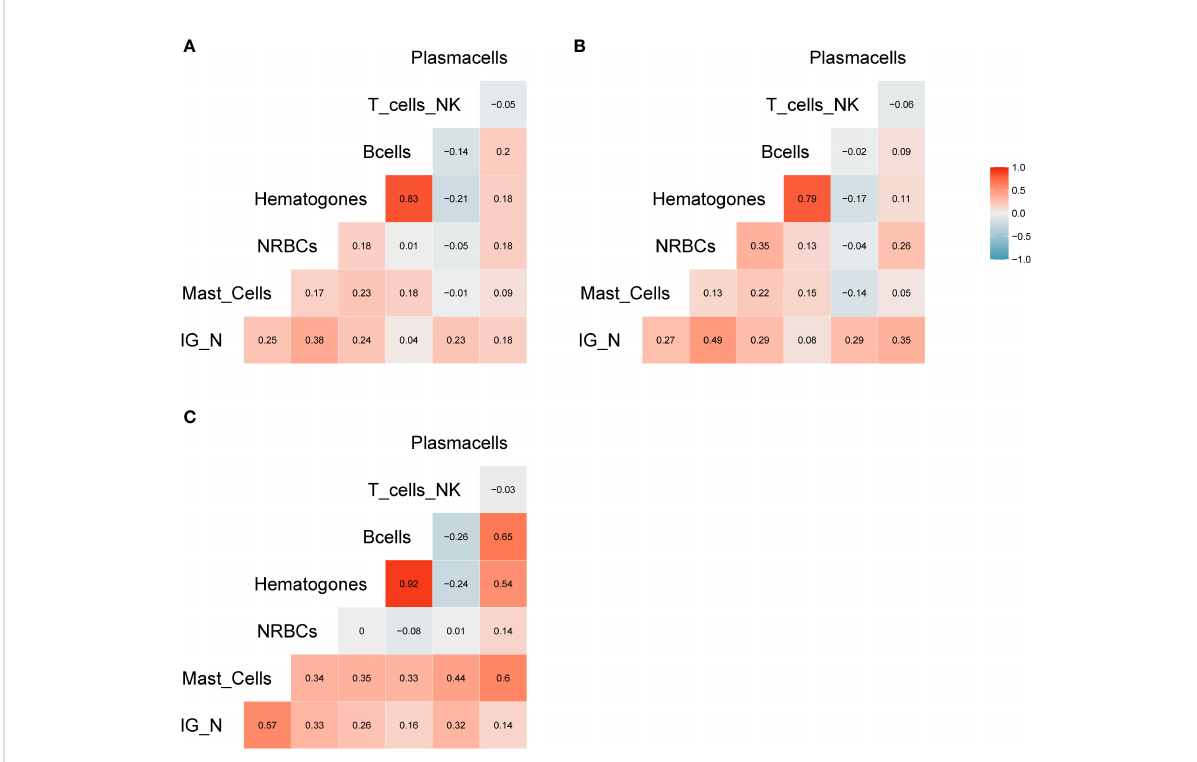
FIGURE 2 Correlation analysis. (A) Correlation matrix related to all samples included in the study; the relative matrices for MM (B) and ALL patients (C) . Positive correlations are displayed in red, while negative correlations are displayed in blue. Color intensity is de fi ned by the correlation coef fi cient. Overall, the Pearson ’ s rho ( R ) for IG/N vs. mast cells and erythroblasts was ~0.3, with